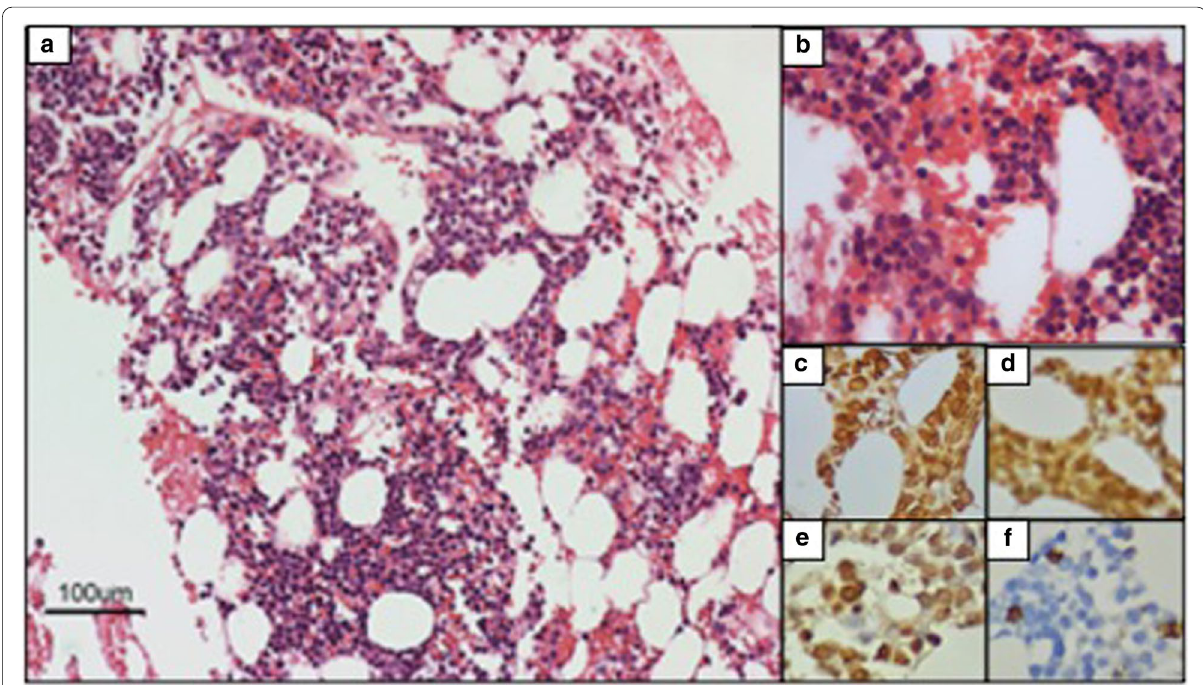
Fig. 2 a Hypercellular bone marrow with interstitial distribution of monocytoid cells and perivascular mature cells; b Monocytoid cell detail; c CD163 ( ) d CD68 ( ) e lysozyme ( ) f CD117 + + +